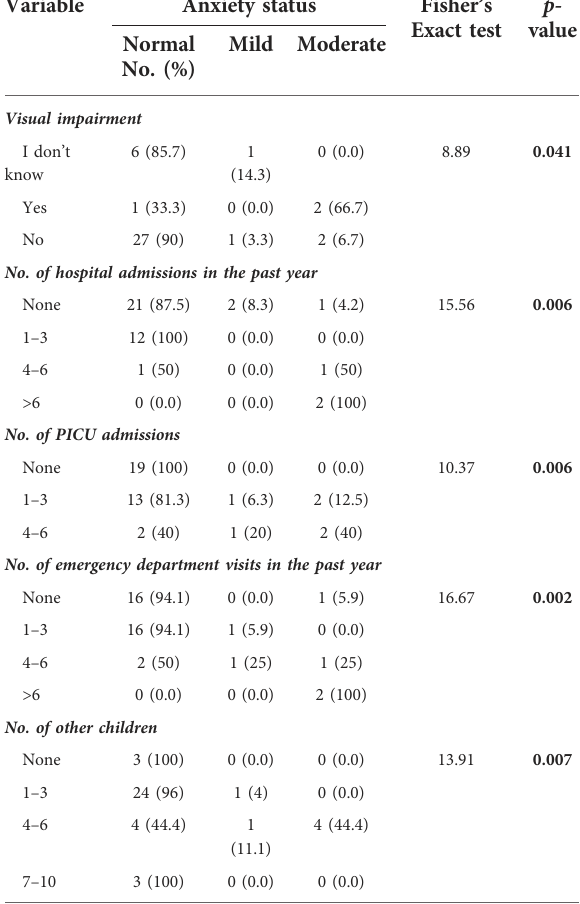
TABLE 4 Relationship between anxiety status and child health status.